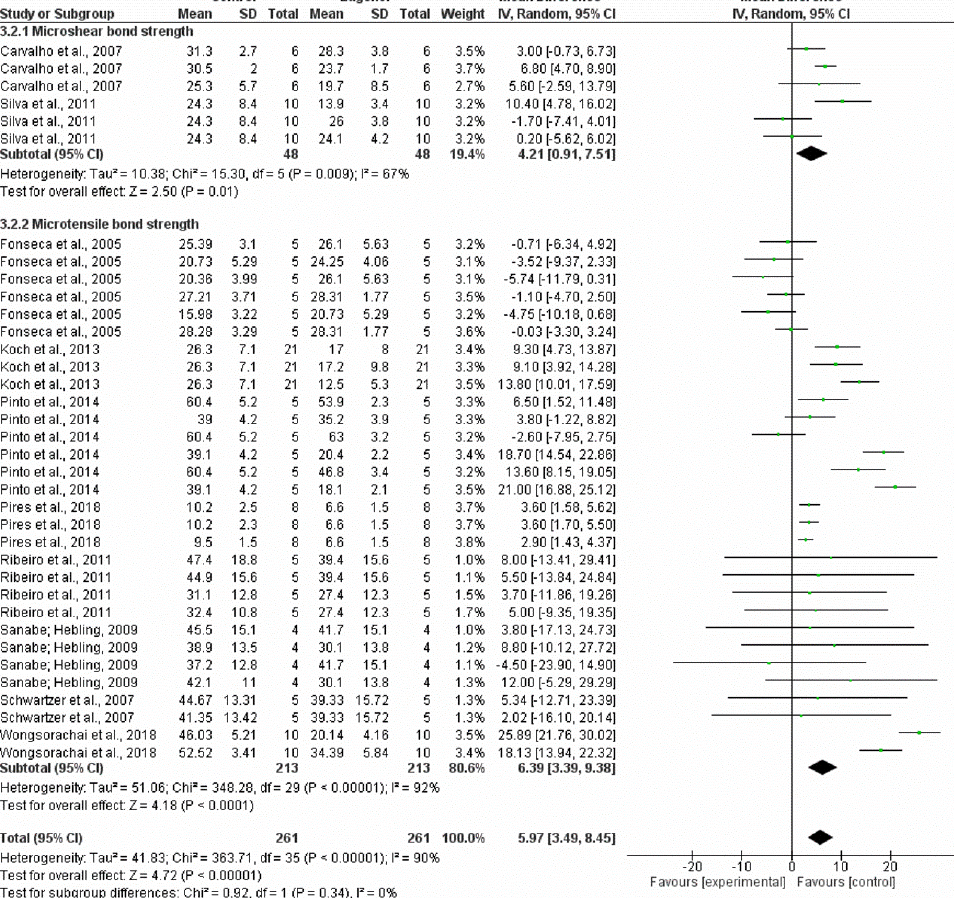
Figure 4. Forest plot of global and subgroups (µSBS or µTBS) meta-analyses. The bond strength of adhesive systems / resin-based restorative materials to coronal dentin after contact with